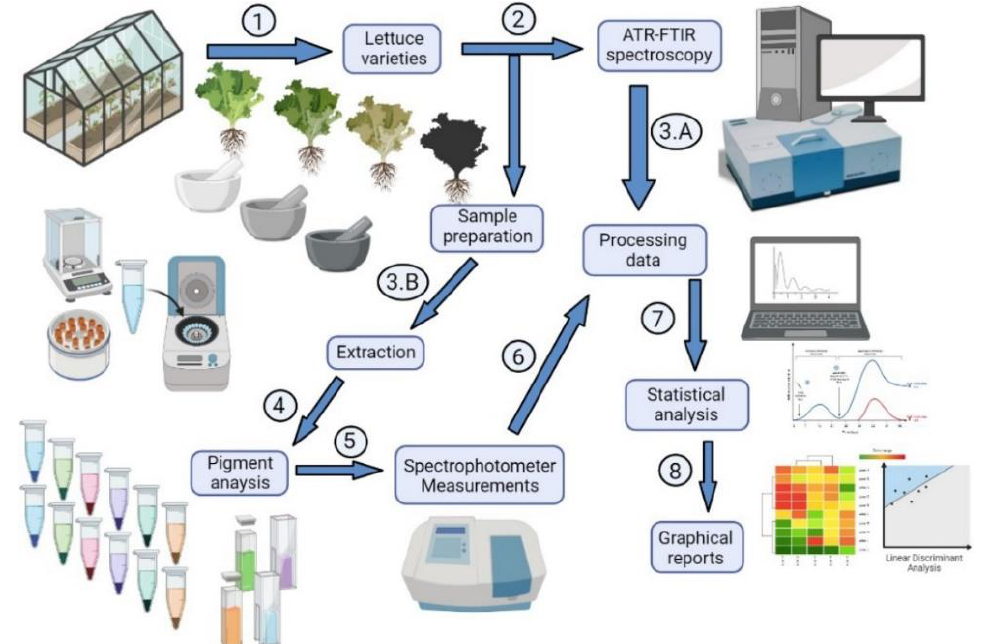
Figure 2. Flowchart describing classified and predicted pigments in Lactuca sativa L. (lettuce varieties) using machine learning and ATR-FTIR spectroscopy for analysis. (1) Greenhouse to grow the lettuce; (2) sample preparation and analysis; (3. A) ATR-FTIR spectroscopy direct analysis; (3. B) material for chemical quantification; (4) pigment extractions in different solvents; (5) analysis in a microreader or spectrophotometer; (6) data processing and multivariate statistical analysis based on machine learning; (7) modelling, calibration, classification, and prediction models; and (8) training, testing, and graphical reports by